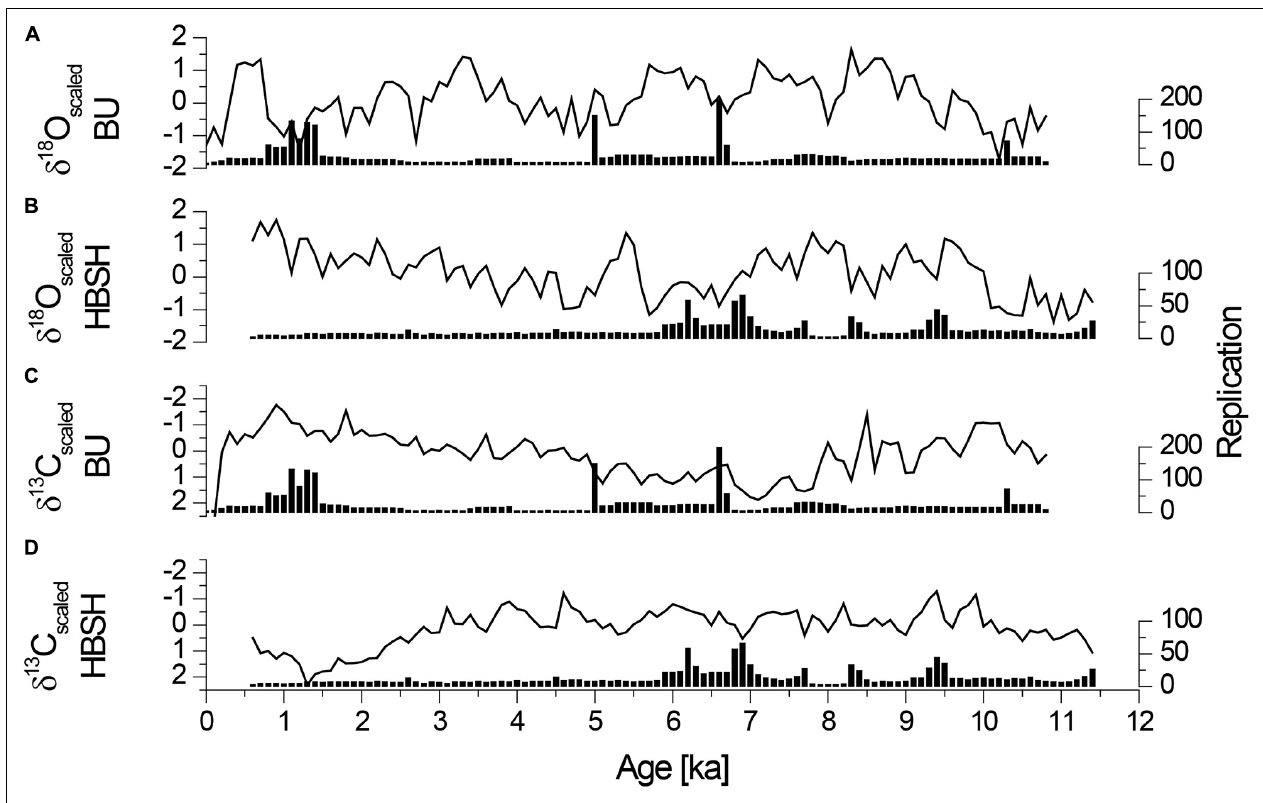
FIGURE 9 | Scaled stable isotope stacks for (A) δ 18 O values from Bunker Cave, (B) δ 18 O values from HBSH, (C) δ 13 C values from Bunker Cave, and (D) δ 13 C values from HBSH. For all stacks, the replication indicates the number of stable isotope measurements averaged for the centennial mean for the specific time interval. Note that the axes for δ 13 C are inverted to match the plots shown in Figures 4 , 5